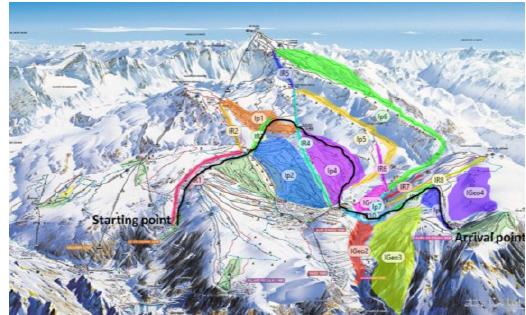
Figure 4. Areas Of Interests for routing task (Task 2). The black line indicates the (ideal) route linking the starting and the arrival